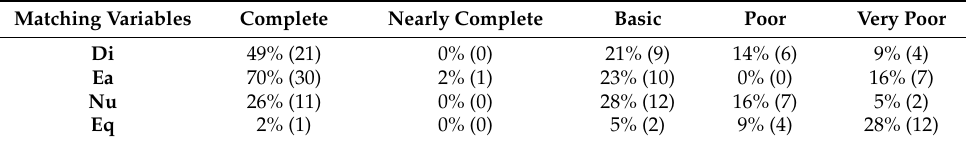
Table 4. Assessment of the matching variables according to Likert